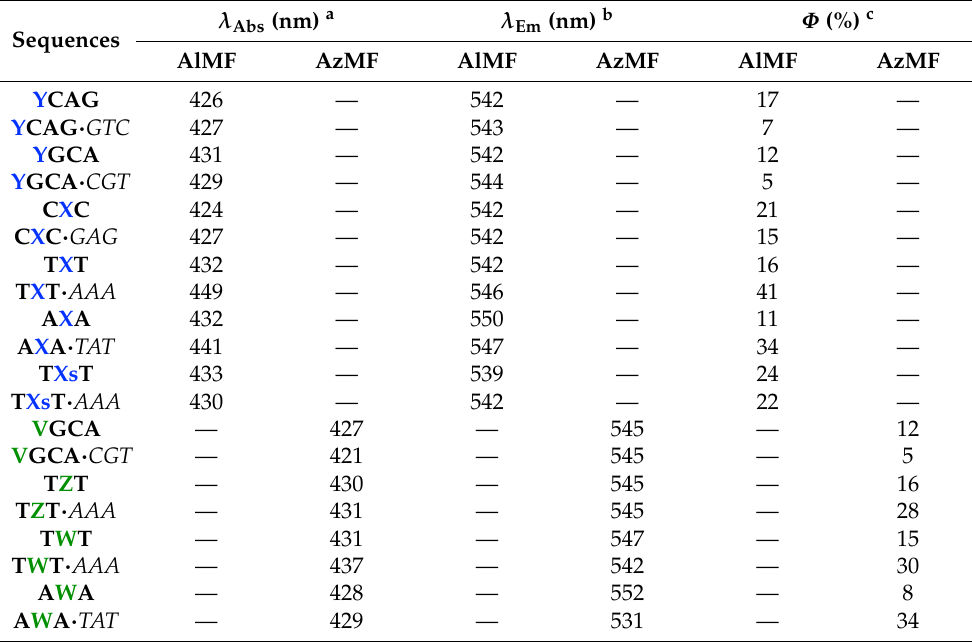
Table 2. Photophysical features of the considered ODNs labeled with AlMF and AzMF .